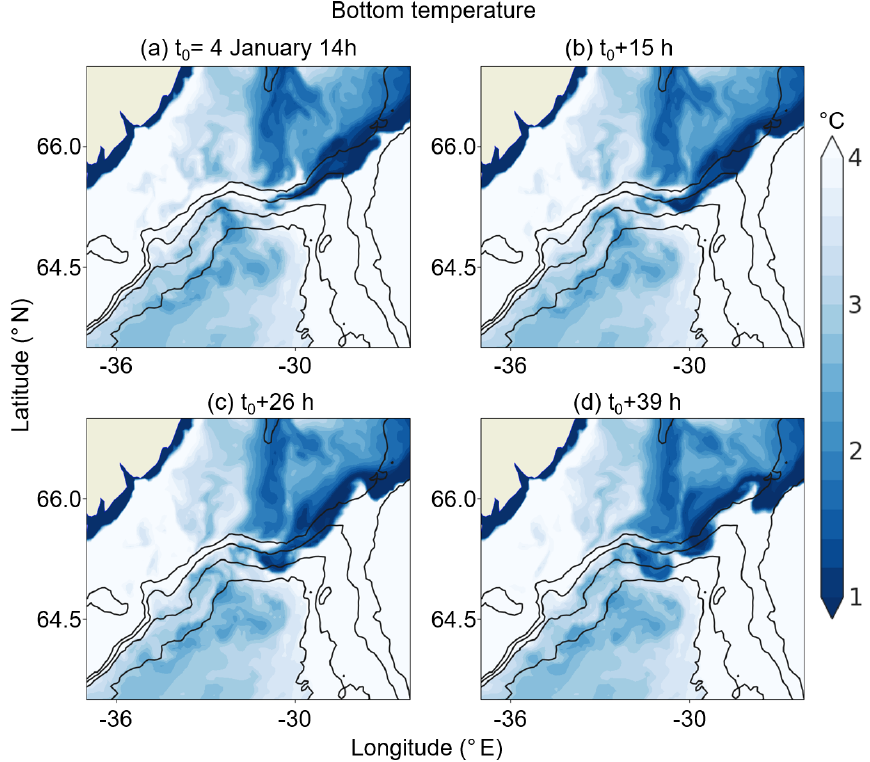
Figure 16. Hourly snapshots of bottom temperature in simulation DSO60.L150 for (a) 4 January at time t 0 = 14h, (b) time t = t 0 + 15h, (c) time t = t 0 + 26h, and (d) time t = t 0 + 39h. The 500, 1000, 1500, and 2000m isobaths are